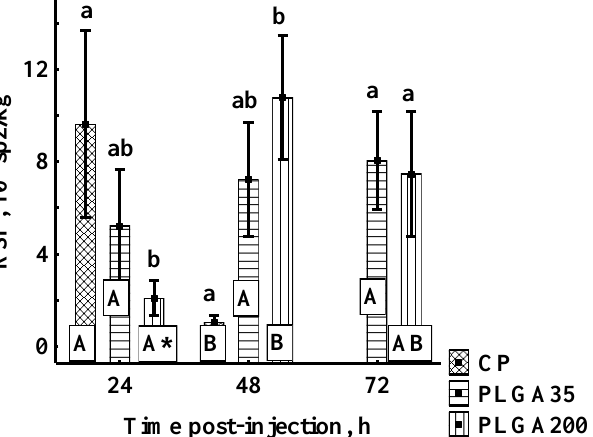
Figure 6. Relative sperm production (RSP) following hormone treatment. Significant differences among groups at a sampling point are indicated by lowercase letters ( p < 0.05). Significant differences within an experimental group are indicated by uppercase letters ( p < 0.05). *—indicates a significant pairwise difference between groups treated by PLGA 200 at 24 h in comparison to groups treated by PLGA200 at 48 h and 72 h post-injection (Mann–Whitney U-test, p < 0.05). Experimental treatments: CP—carp pituitary extract, dose 4 mg/kg; PLGA35—Alarelin, dose 35 µ g/kg; PLGA200—Alarelin, dose 200 µ g/kg.